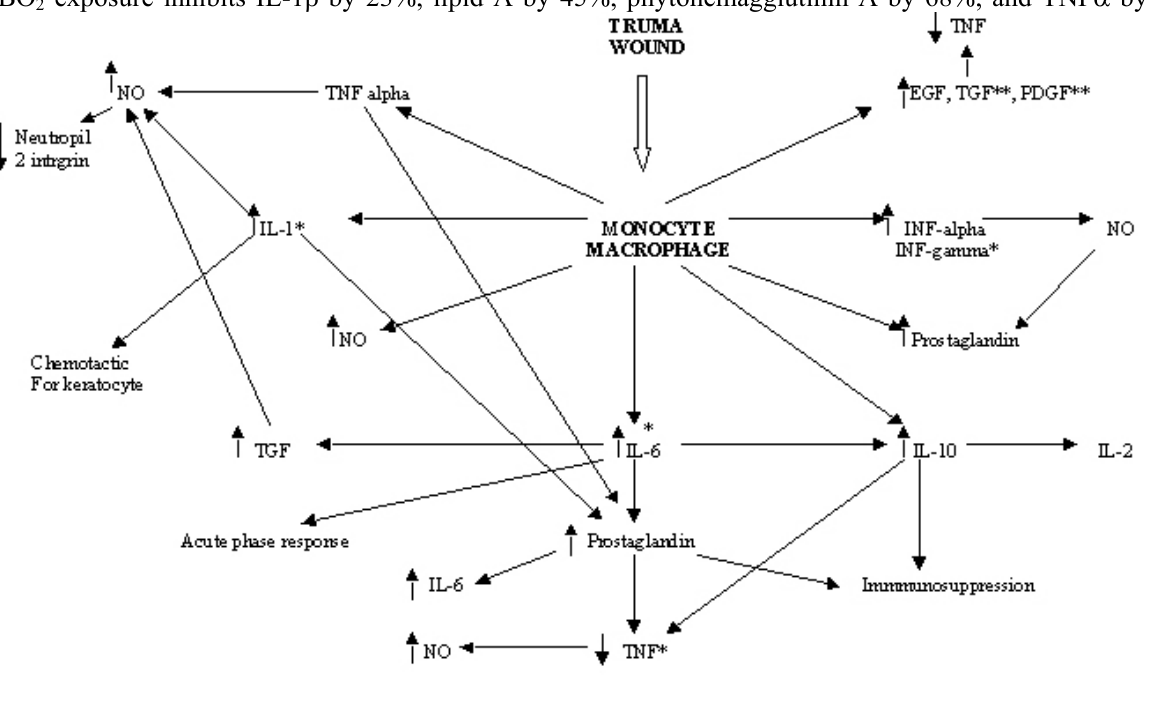
FIGURE 3 . Interaction between cytokines, PGs, and NO. *Inhibited by HBO 2 . **Elevated by HBO 2 .